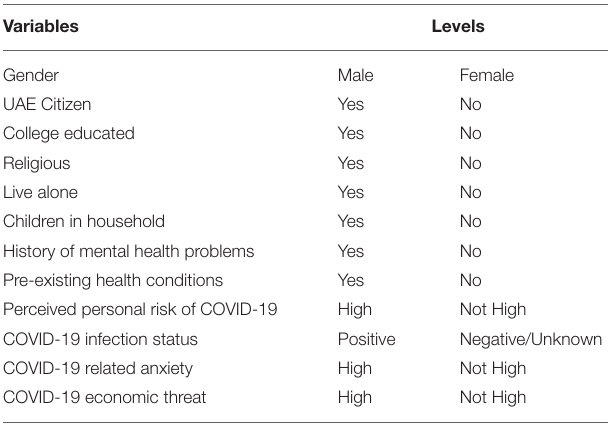
TABLE 2 | The study’s main categorical variables with levels. Variables Levels